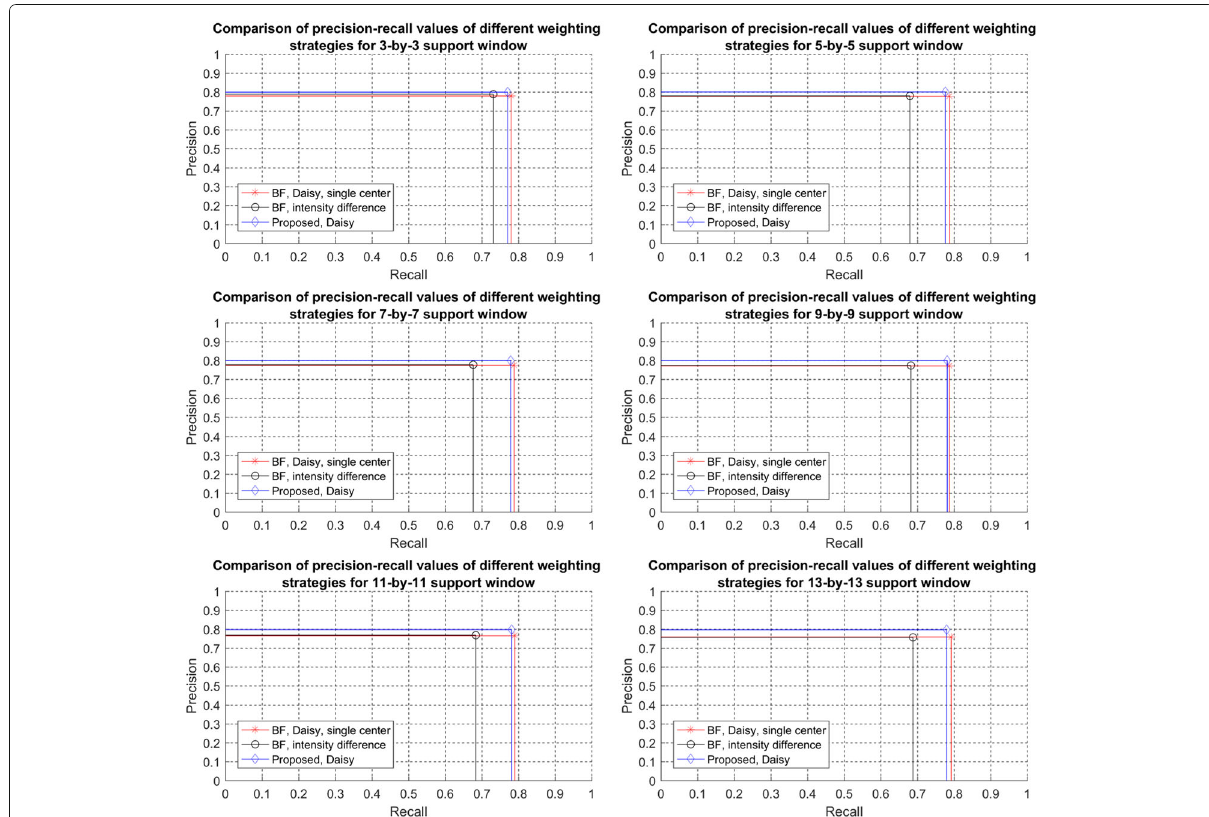
Fig. 7 Performance comparison of the proposed and two other bilateral-filtering-based weighing strategies on the stereo pair in Fig. 4(b)